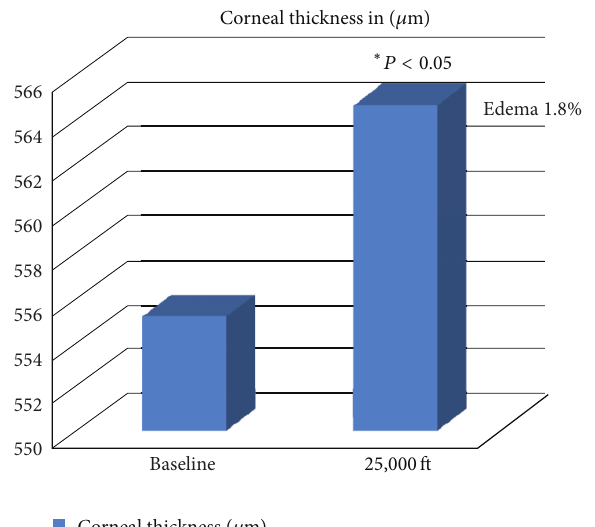
Figure 2: Pachymetry values related to corneal thickness in con- ditions of hypobarism revealed a statistically significant increase ( 𝑃 < 0.05 ). The average normobaric value was 555.14 ± 14.7 (SD) 𝜇 m versus 564.64 ± 16.5 (SD) 𝜇 m in hypobaric conditions, at 25,000